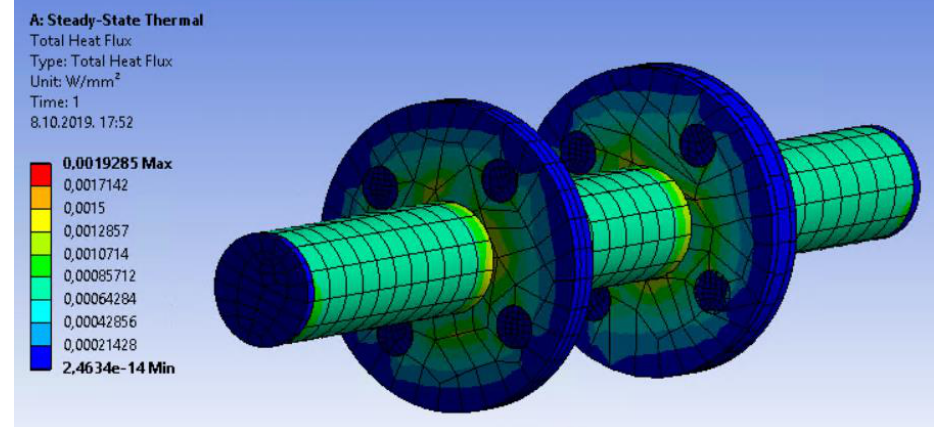
Figure 9. Calculated distribution of heat flow density for adiabatic line with two gaps .